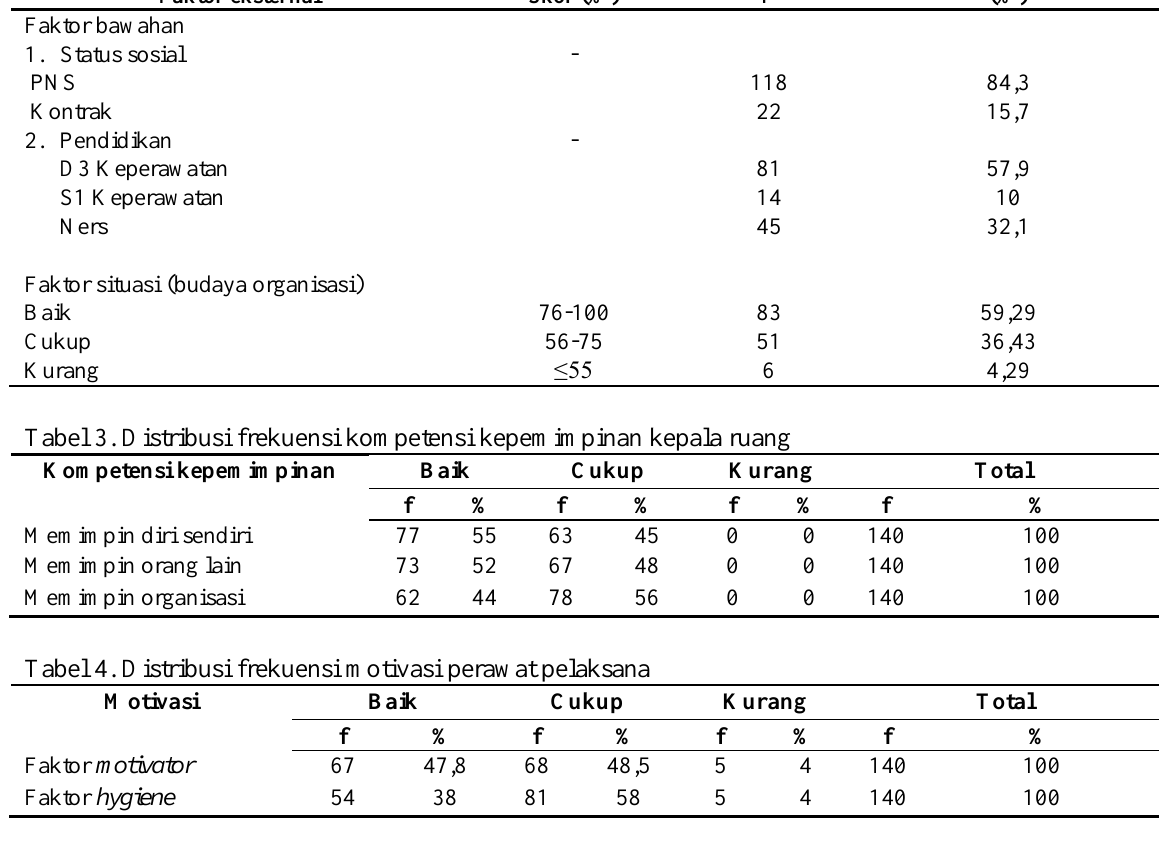
Tabel 5. Distribusi frekuensi kinerja perawat pelaksana